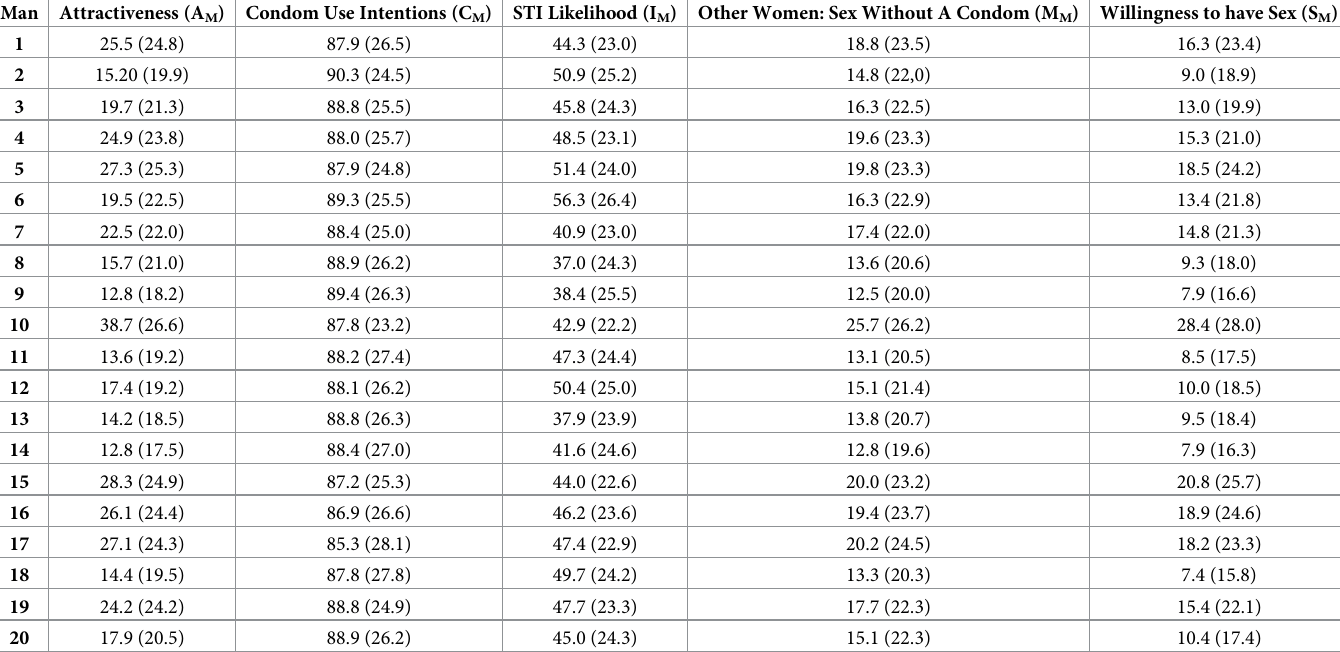
Table 1. The mean participant ratings for each male photograph (Scale 0–100). The standard deviation is shown in parentheses.